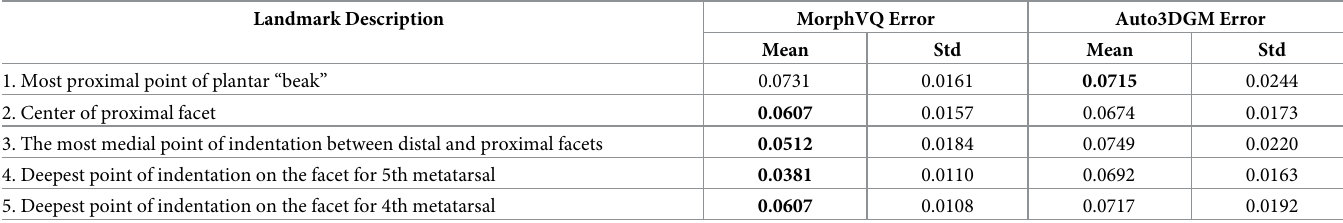
Table 3. Mean Euclidean distance between estimated points and ground-truth landmarks. Landmark